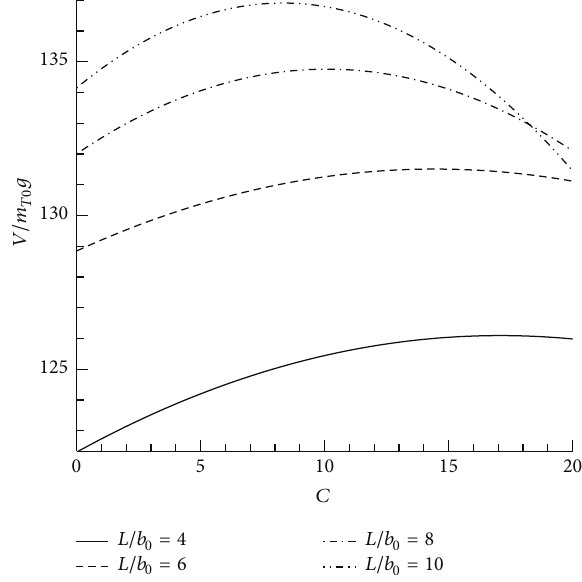
Figure 12: Tapering and length effects on bimorph with parallel connection, with tip